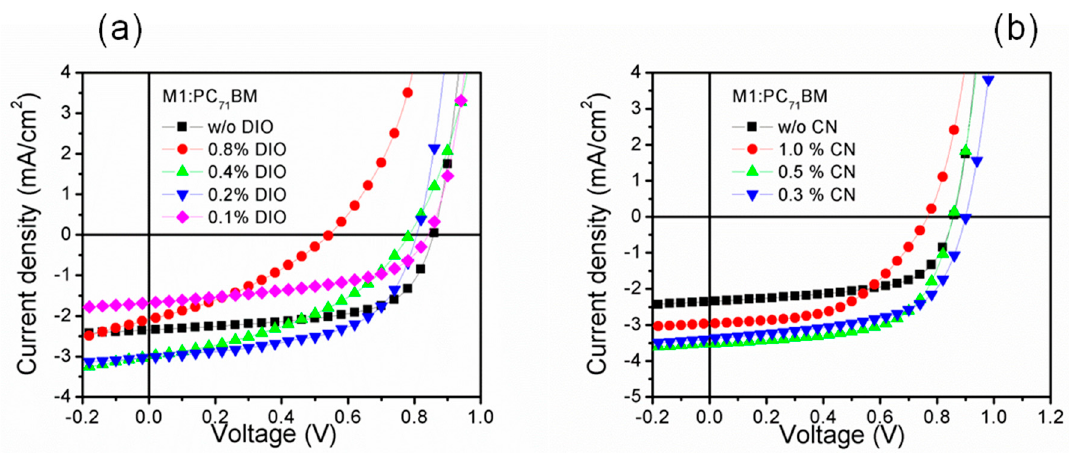
Figure 3. J-V characteristics of M1 :PC 71 BM (40:60) solar cells cast from chlorobenzene incorporating different amounts of solvents additives: ( a ) 1,8-diiodooctane (DIO) and ( b ) chloronaphthalene (CN). Table 2. Summary of device parameters of SM-BHJ solar cells based on M1 :PC 71 BM active layers (40:60 in chlorobenzene) incorporating different amounts of DIO and CN additives. All values are averaged from five devices with two electrodes on top of each device and a standard deviation within ± 4%. M1:PC 71 BM (40:60, w / w Ratio in Chlorobenzene)